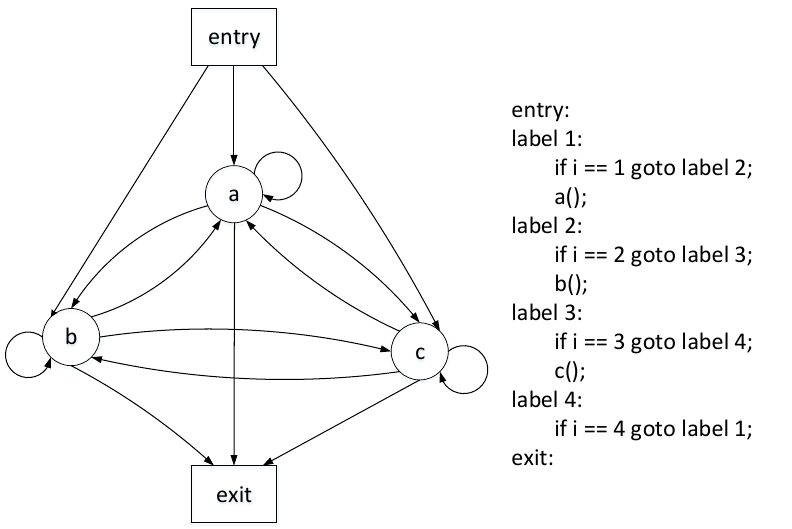
Figure 7. Control Flow Sequence of lifecycle Methods When There are Multiple Fragments